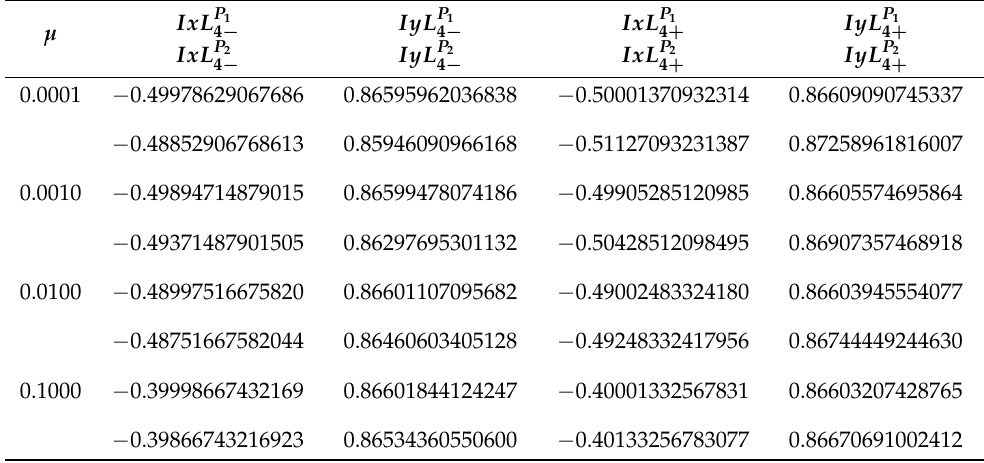
Table 8. In-ine equilibrium solution of the restricted 2 + 2 body problem near L 4 .